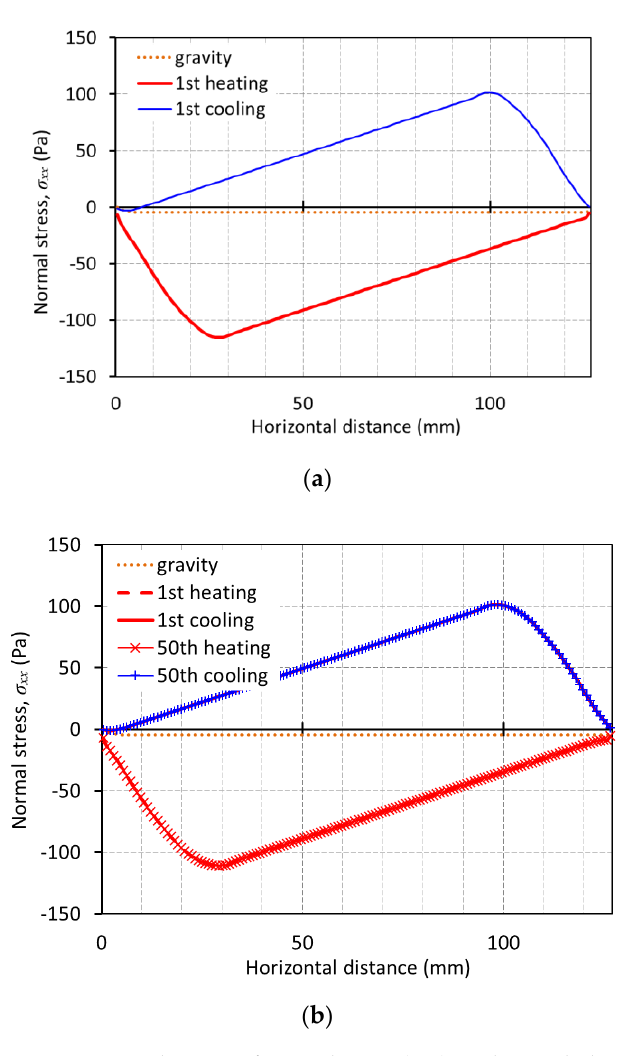
Figure 12. Distributions of normal stress ( σ xx ) on the acryl plate. The presented results are based on ∆ T = 31 ◦ C in β = 10 ◦ slope with the parameters in Table 1. ( a ) and ( b ) are the same as in Figure